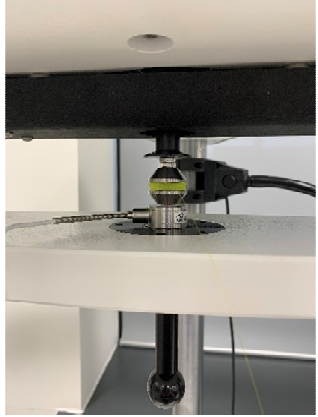
Figure 1. Fibre optic sensor with eight FBGs secured on the membrane. The center wavelength (in nm) of each sensor is shown.